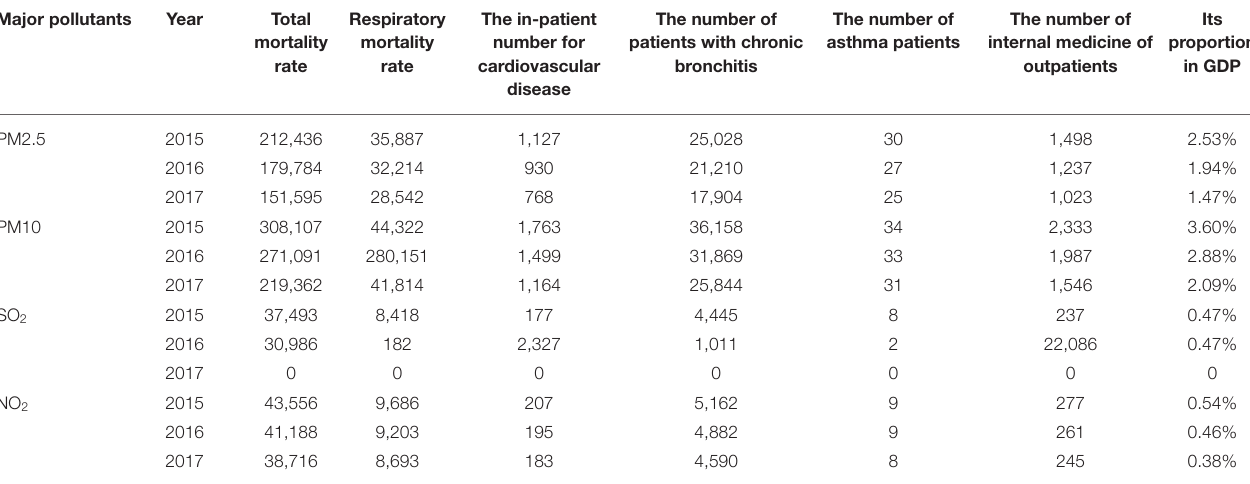
TABLE 8 | Economic losses caused by various pollutants in Z City, from 2015 to 2017 (ten thousand) Unit: US dollar. Major pollutants